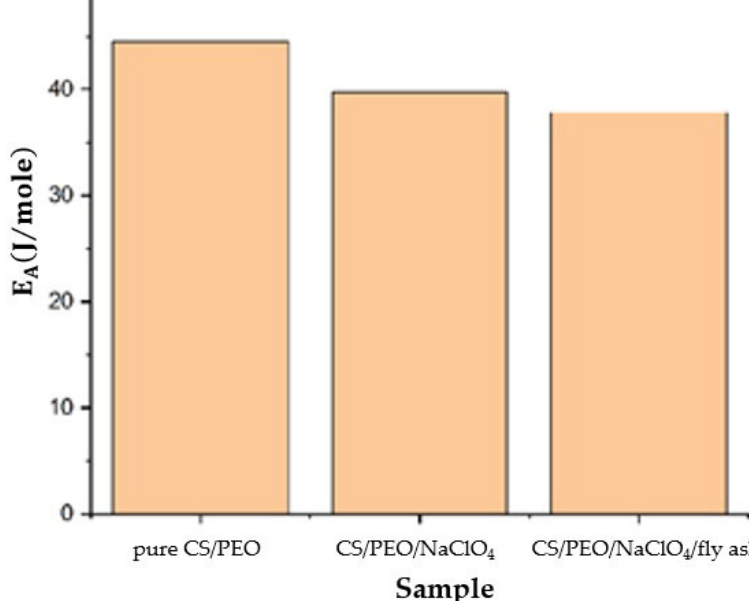
Figure 8. Activation energy for, ( A ) pure CS/PEO, ( B ) CS/PEO/NaClO 4 , ( C ) CS/PEO/NaClO 4 /fly ash.